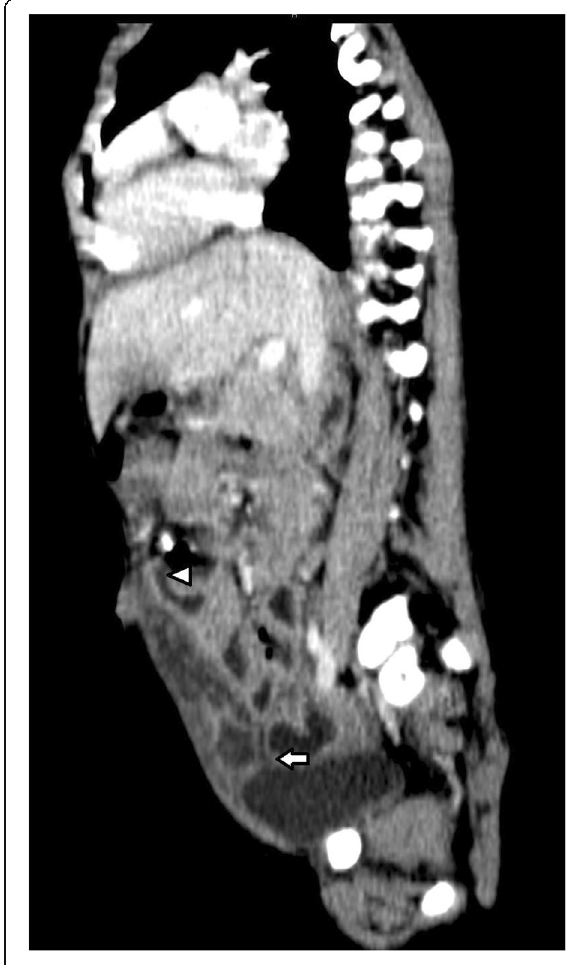
Fig. 1 Sagittal view of the abdominal CT showing multiloculated urachal abscess extending from the bladder dome (arrow) to the umbilicus (arrow